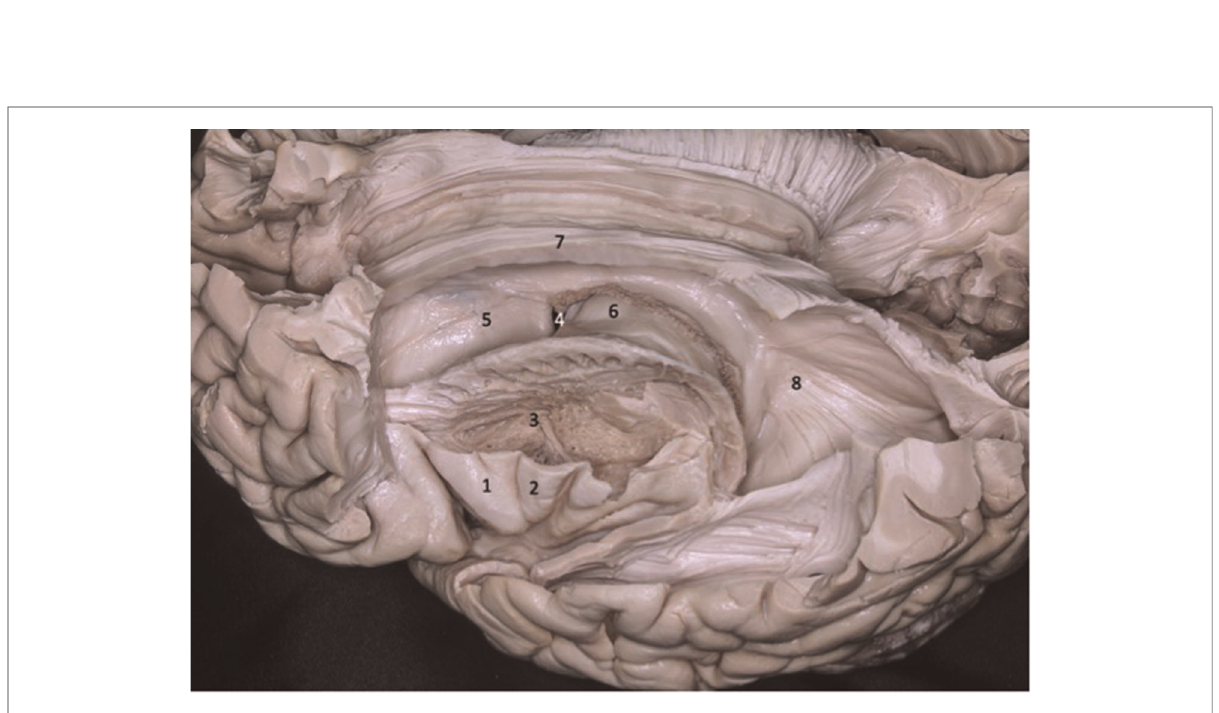
FIGURE 2 Lateral view of the left cerebral hemisphere. Part of the frontal and temporal lobes were removed to expose the insula, basal ganglia, and ventricular system. The second short gyrus of the insula (2) aligned with the foramen of Monro (4). The foramen of Monro is located medially to the knee of the internal capsule. 1 - fi rst short gyrus of the insula; 2 - second short gyrus of the insula; 3 – basal ganglia; 5 - caudate nucleus head; 6 - thalamus; 7 - corpus callosum; 8 - lateral ventricle